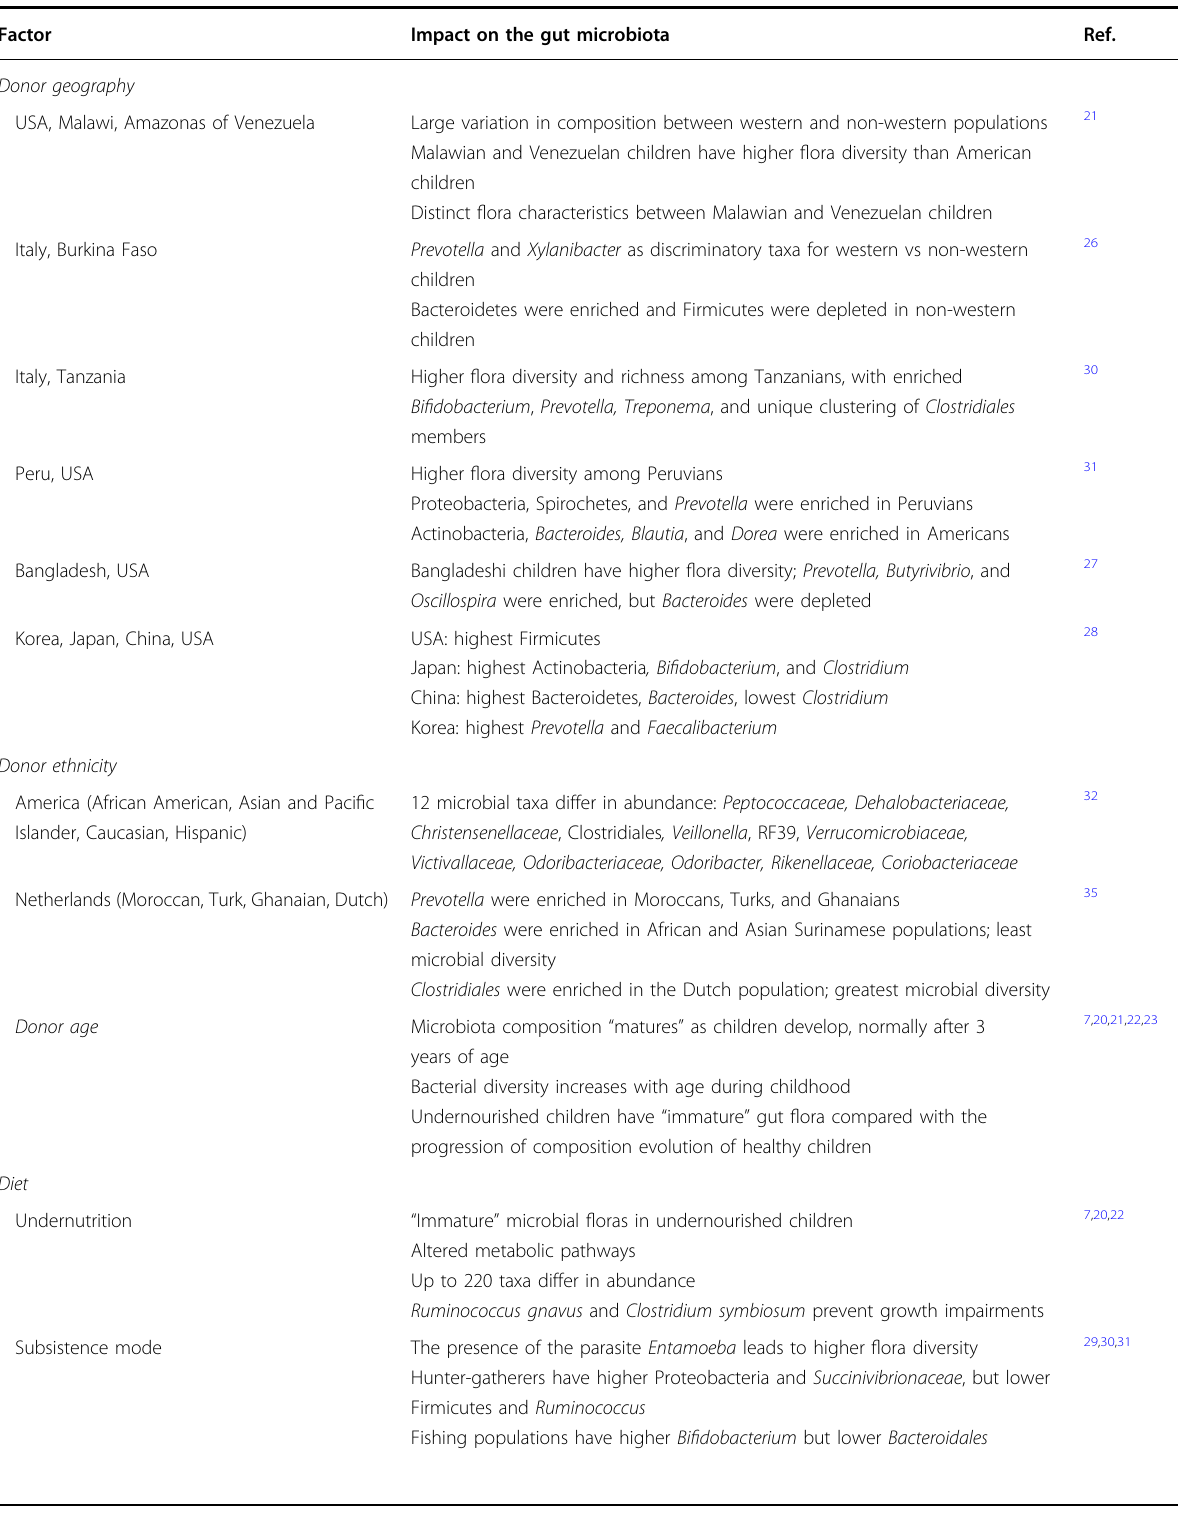
Table 1 Factors affecting the human gut